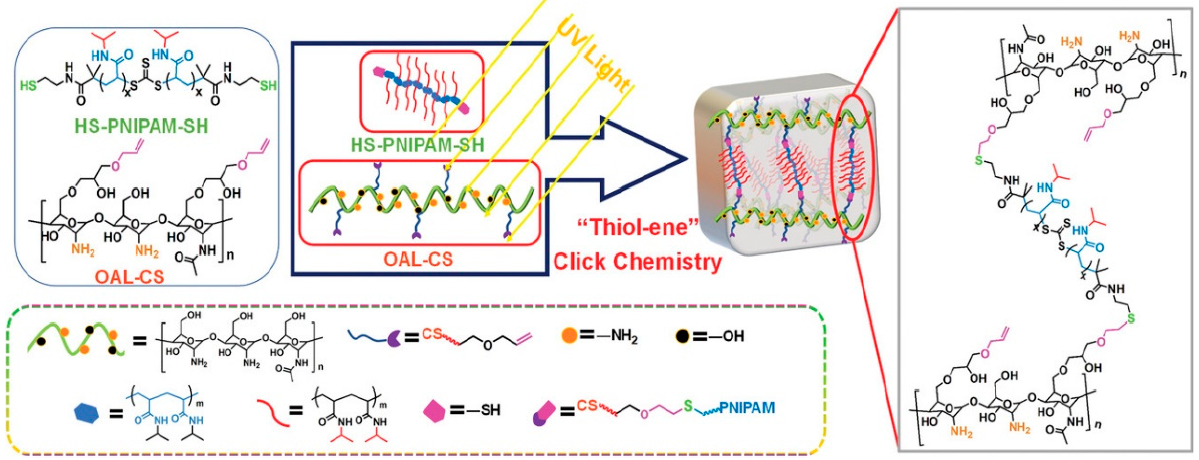
Figure 3. The design and preparation of dual pH- and thermo-responsive OAL-CS/PNIPAM hydro- gel via thiol-ene click chemistry. Reprinted with permission from [83].